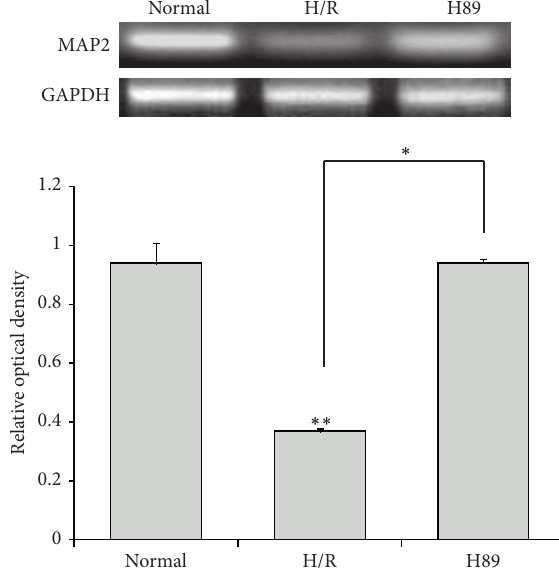
Figure 4: The measurement of MAP2 mRNA level in Neuro2A cells after PKA inhibitor treatment. MAP2 mRNA levels were measured by using RT-PCR. The H89 group showed higher mRNA levels of MAP2 compared to the hypoxia reperfusion injury group. Data were expressed as mean ± S.E.M, and each experiment included 3 repeats per condition. GAPDH was used as a control. Differences were considered significant at ∗ 𝑃 < 0.05 and ∗∗ 𝑃 < 0.001 . Normal: the normal control group, H/R: 4hr hypoxia and 18hr reperfusion injury group, and H89: 2hr PKA inhibitor H89 treatment group before 4 hr hypoxia and 18 hr reperfusion